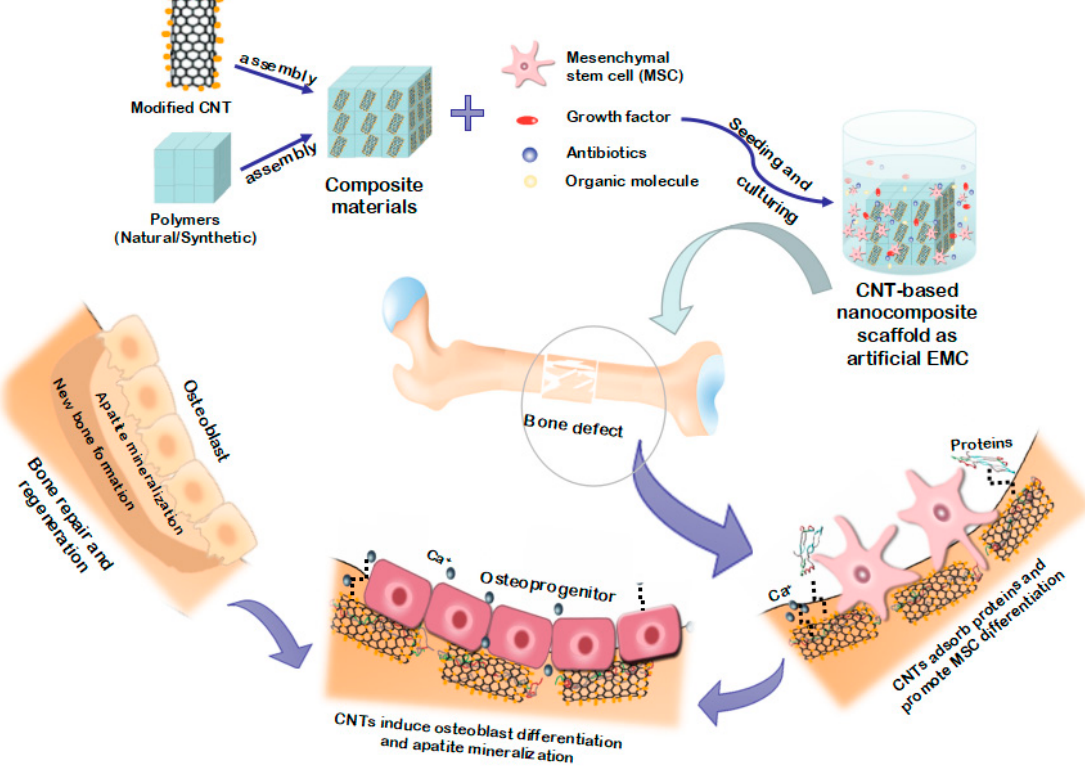
Figure 1. Schematic diagram describing the role of carbon nanotubes (CNTs) as scaffold composites in bone tissue engineering and regeneration.